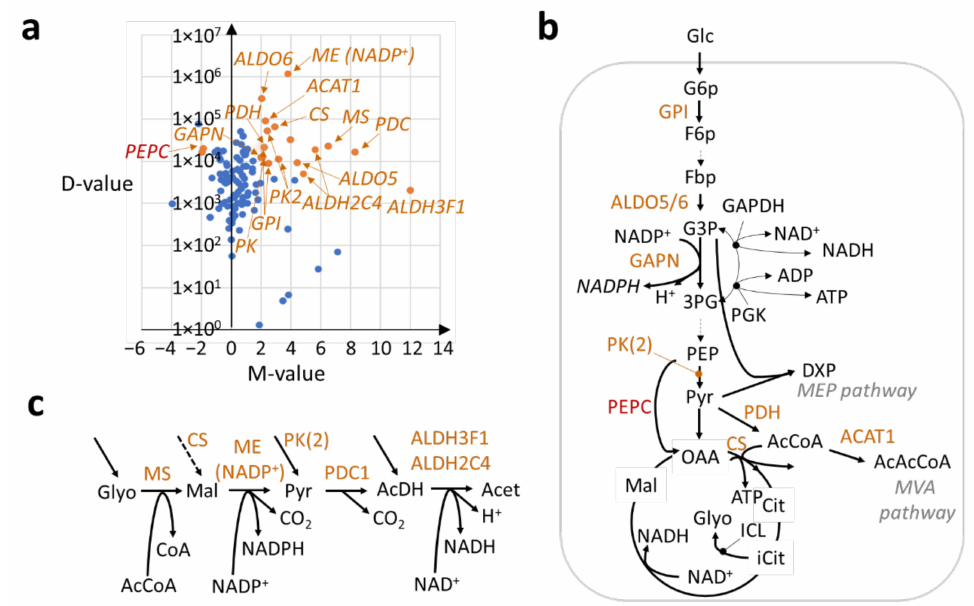
Figure 2. Transcriptional regulation of central metabolism in the trichomes of Cannabis cultivars with respect to stem tissue. ( a ) M-D plot of mean expression values (TMM) of genes encoding en- zymes involved in the central metabolism (the glycolytic pathway, pyruvate metabolism, the pentose phosphate pathway, and the tricarboxylic acid cycle). Filled orange circles denote differentially up- regulated genes of interest, while filled blue circles represent all other genes in the central metabolism. It should be noted that PEPC is significantly down-regulated. ( b ) Pathway diagram of the central metabolism with corresponding enzyme names marked in red/orange. Note that ICL had very low expression. ( c ) Similar diagram for NAD(P)H replenishment pathway. Refer to Table S8 for